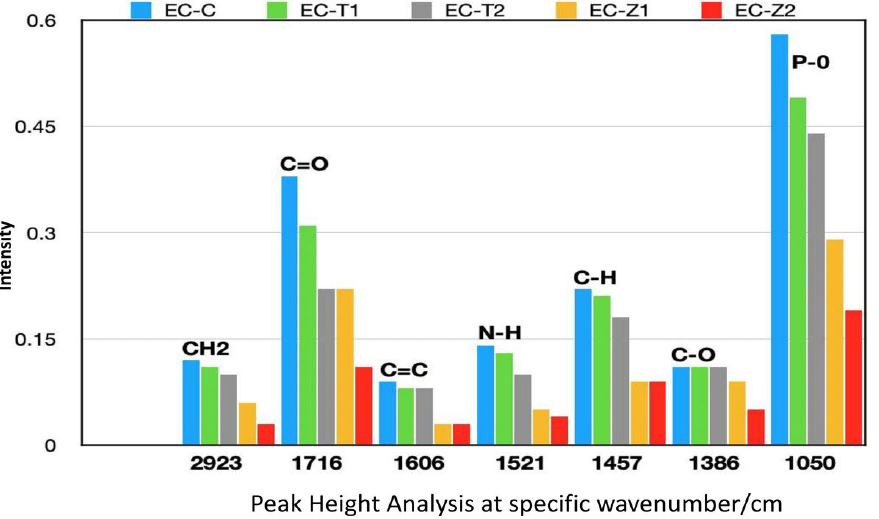
Figure 4. Peak height analysis of control (E) and experimental samples (EZ1, EZ2, ET1, and ET2)) at various regions.